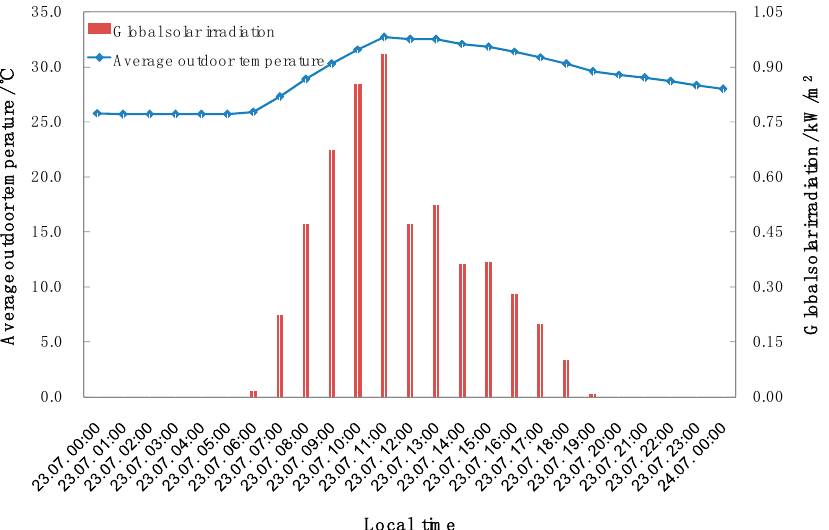
Figure 2. The hourly average outdoor temperature and global solar irradiation on 23 July 2018.